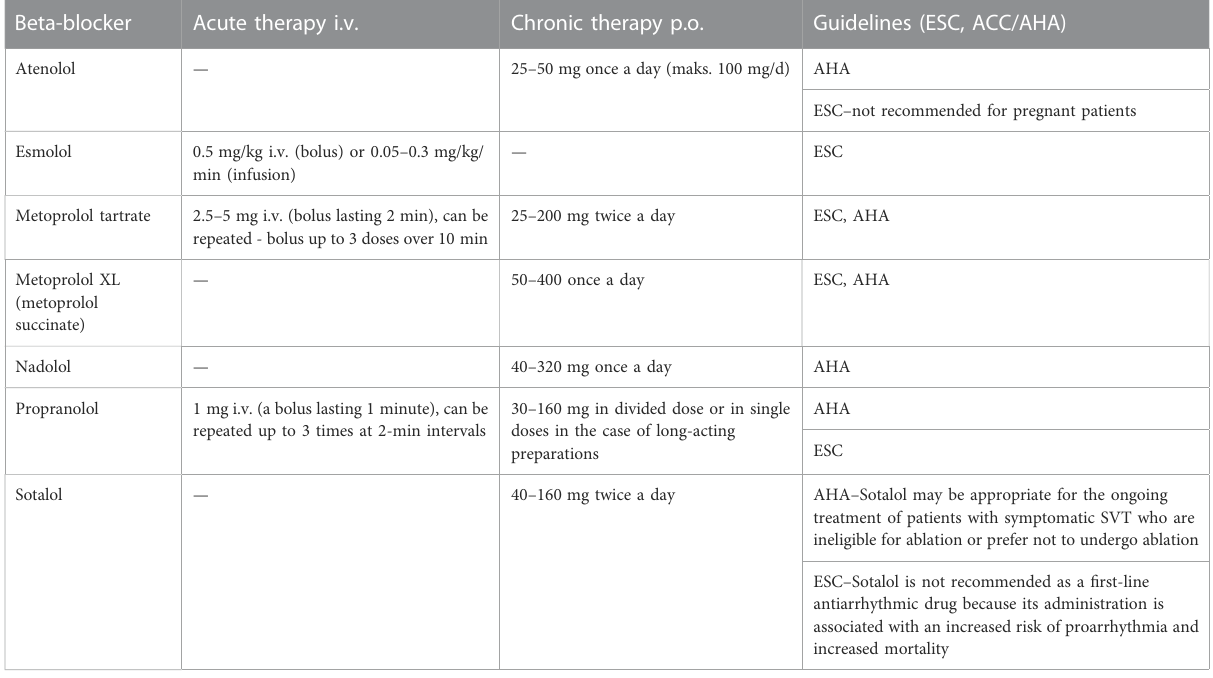
TABLE 5 Dosage of beta-blockers in the treatment of SVT (Page et al., 2016; Brugada et al., 2020).